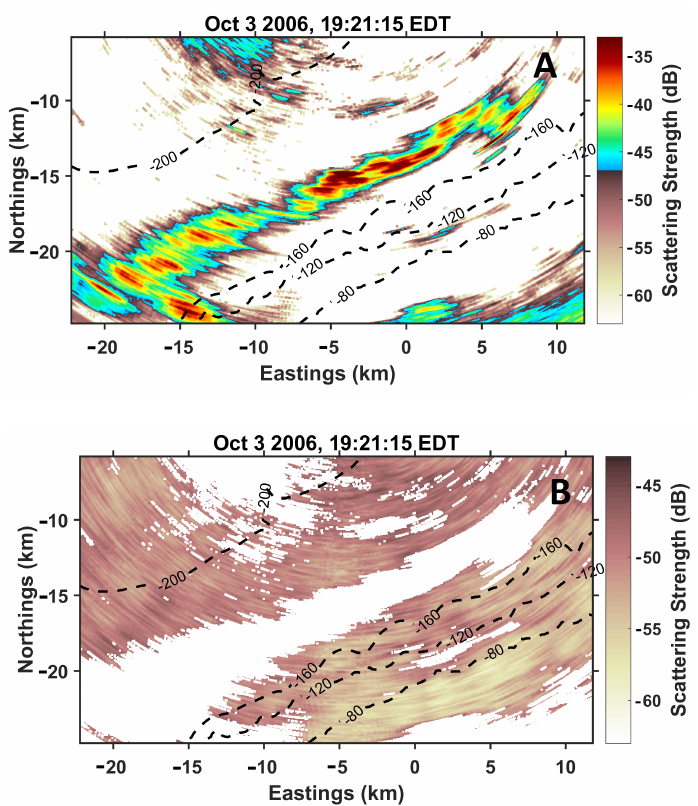
Figure 4. Each pixel in Figure 3B measured on 3 October, 19:21:15 EDT is classified as being dominated by fish or seafloor scattering with the likelihood ratio test of Equation (3). ( A ) Pixels classified as dominated by fish scattering. ( B ) Pixels classified as dominated by seafloor